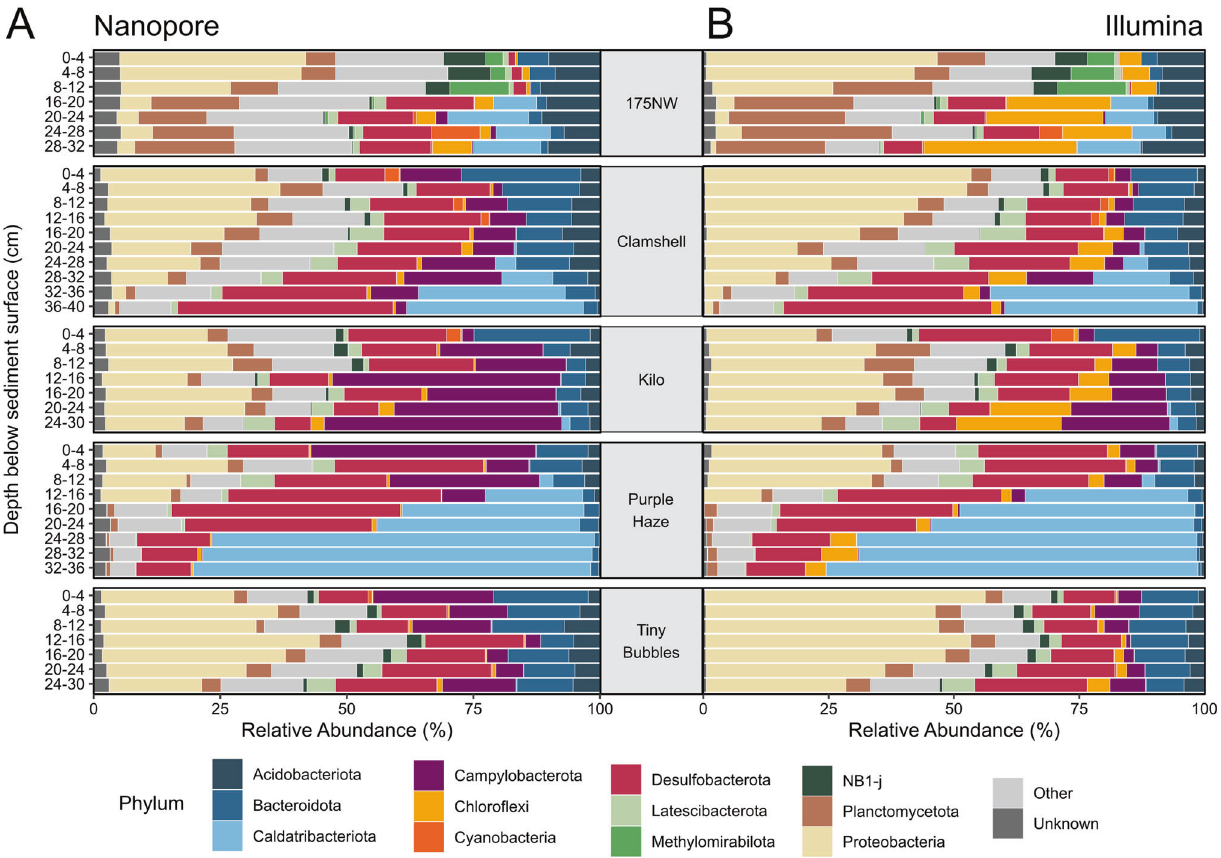
Fig. 3 Relative abundance of most abundant phyla. A Abundance of phyla across samples from Nanopore data set. B Abundance of phyla across samples from Illumina data set. “ Unknown ” represents the sequences not identi fi ed at the phylum level and “ Other ” represents the less abundant